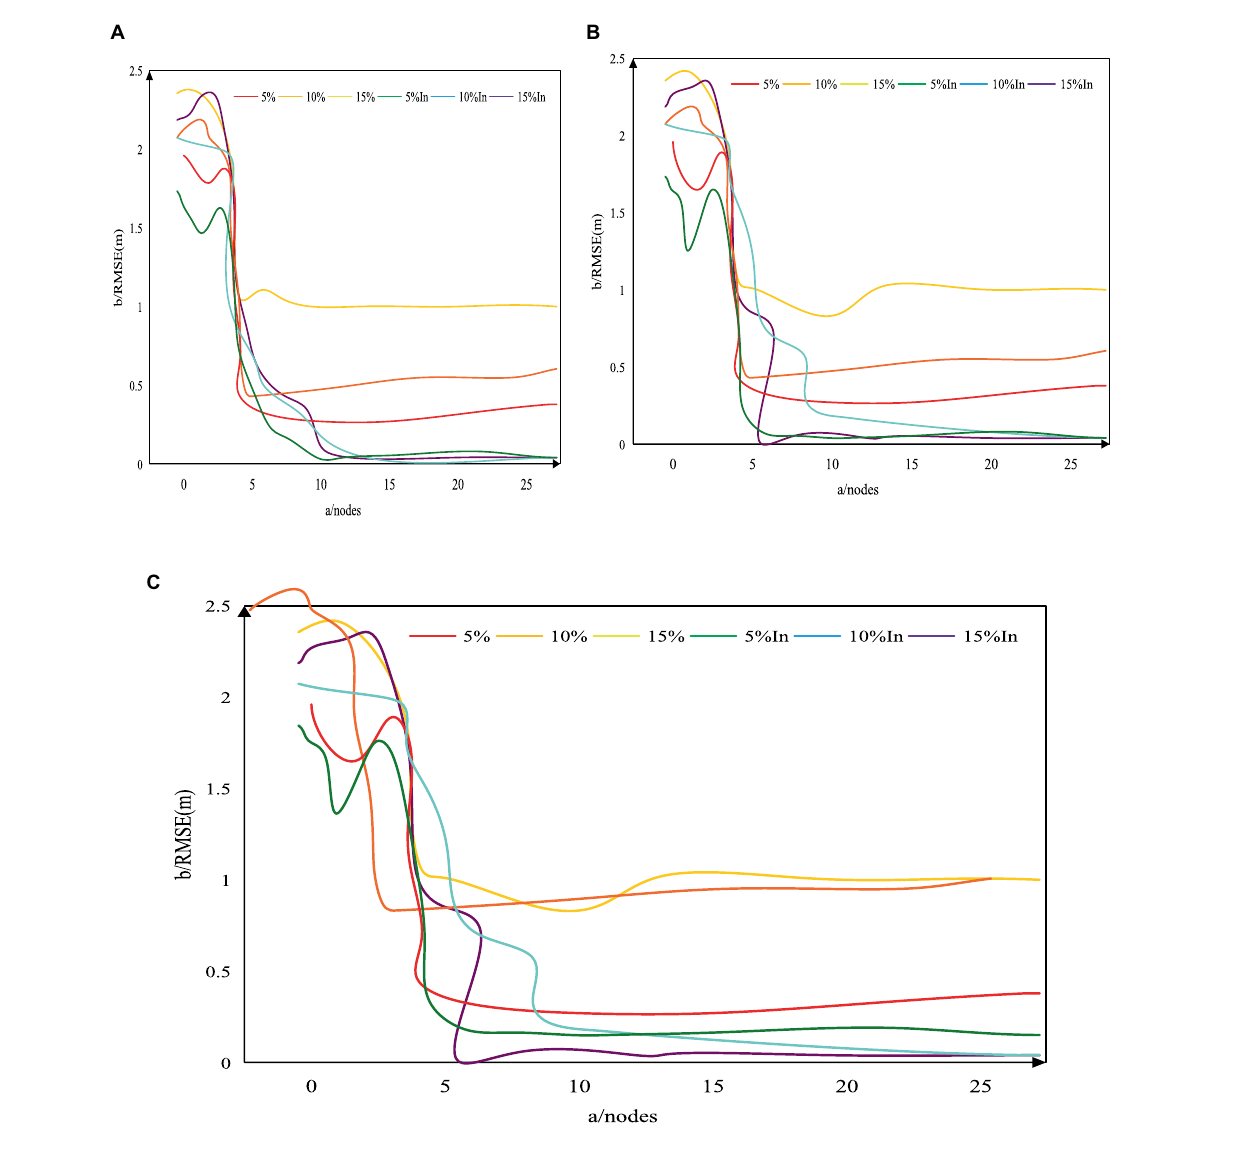
FIGURE 8 Analysis of noise localization results with different values. (A) The localization results of different concentrations of noise when the value is 0. (B) The localization results of different concentrations of noise when the value is 0.5. (C) The localization results of different concentrations of noise when the value is